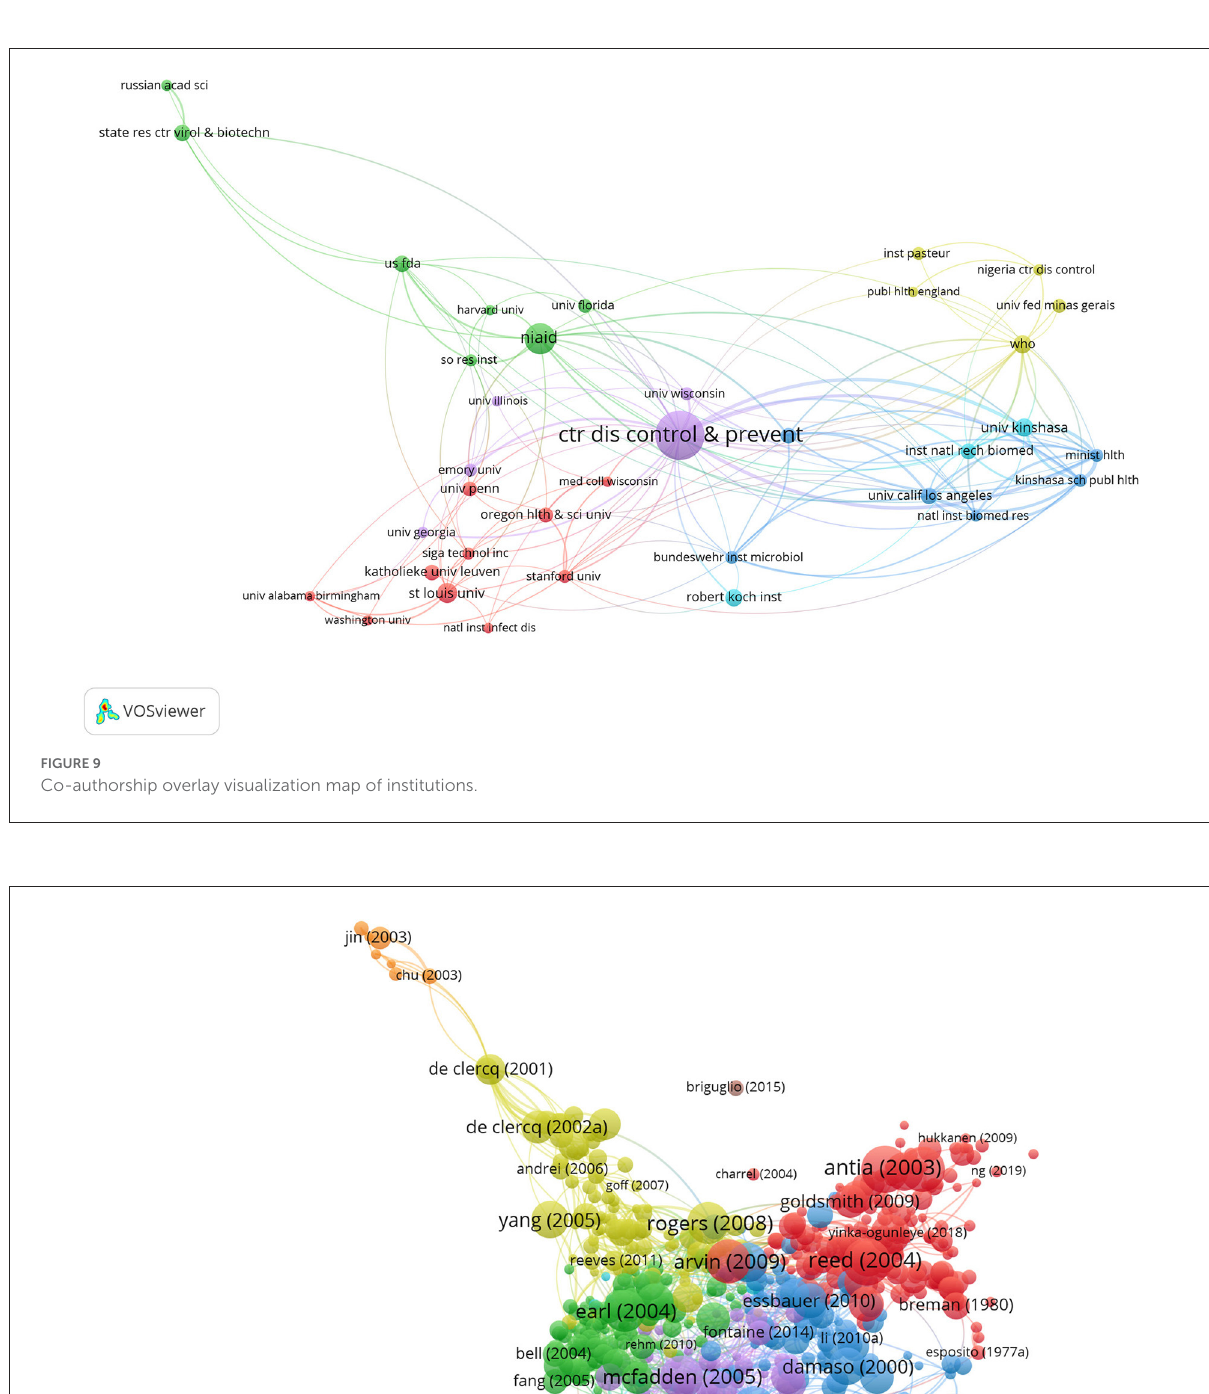
FrontiersinPublicHealth